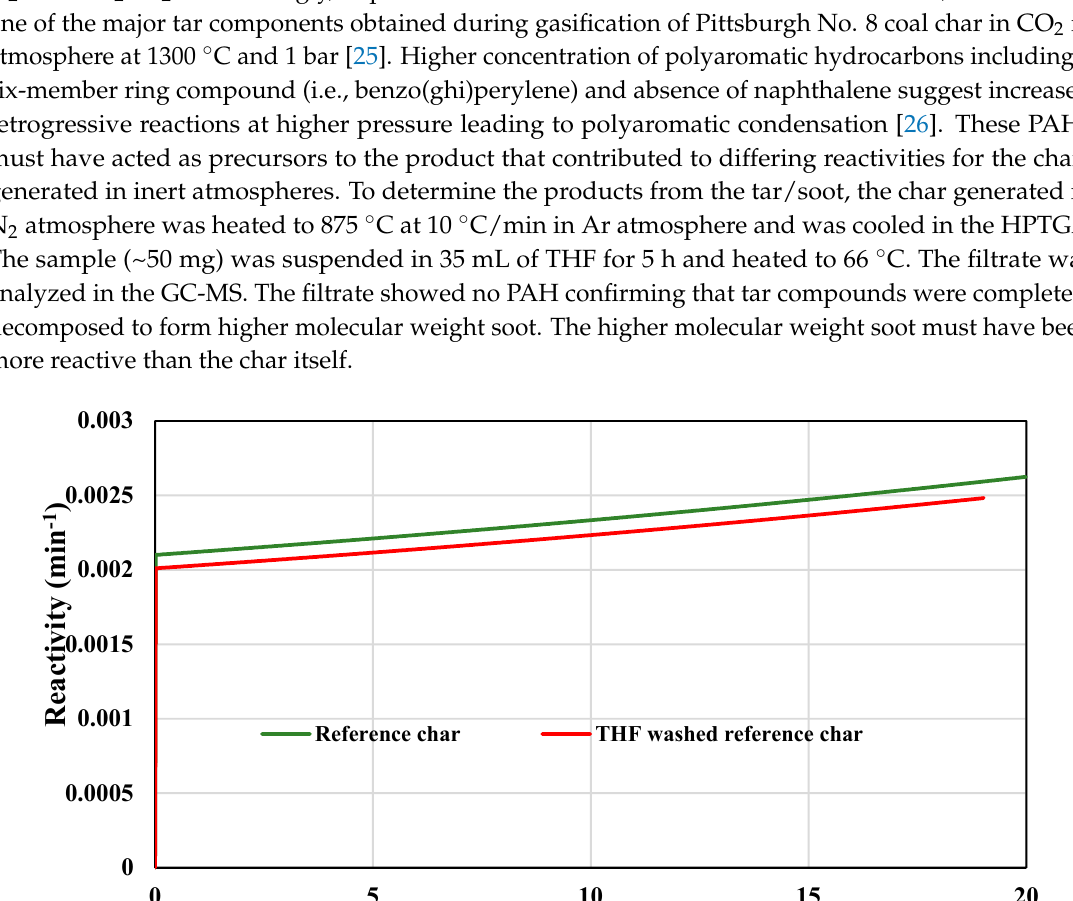
100 Figure 11 . GC-MS chromatograms of THF soluble tars obtained by washing chars generated in CO 2 /N 2 and N 2 atmospheres (only qualitative analysis).